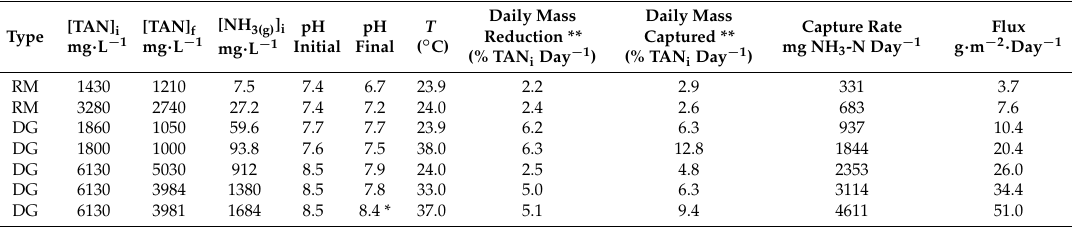
Table 1. Summary of results and donor characteristics from trials using raw manure (RM) and digestate (DG). Each trial lasted 7